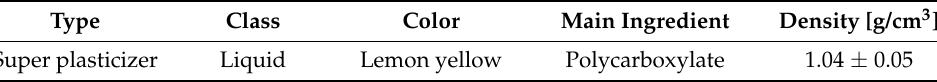
Table 3. Basic physical properties of chemical